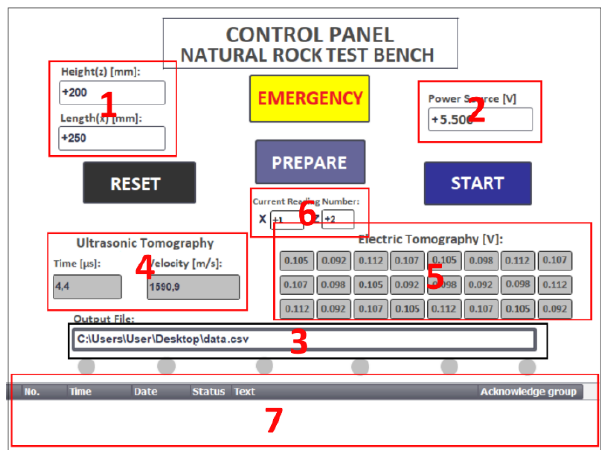
Figure 10. HMI and SCADA main control panels. 1-Input parameters — stone block; 2-Input parameters — power source; 3-Input parameters — csv file for data storing; 4-Measurement Data output from ultrasonic tomography; 5-Measurement Data output from electric tomography; 6-Output information about the number of readings; 7-Output field allocated for machine failures/messages.